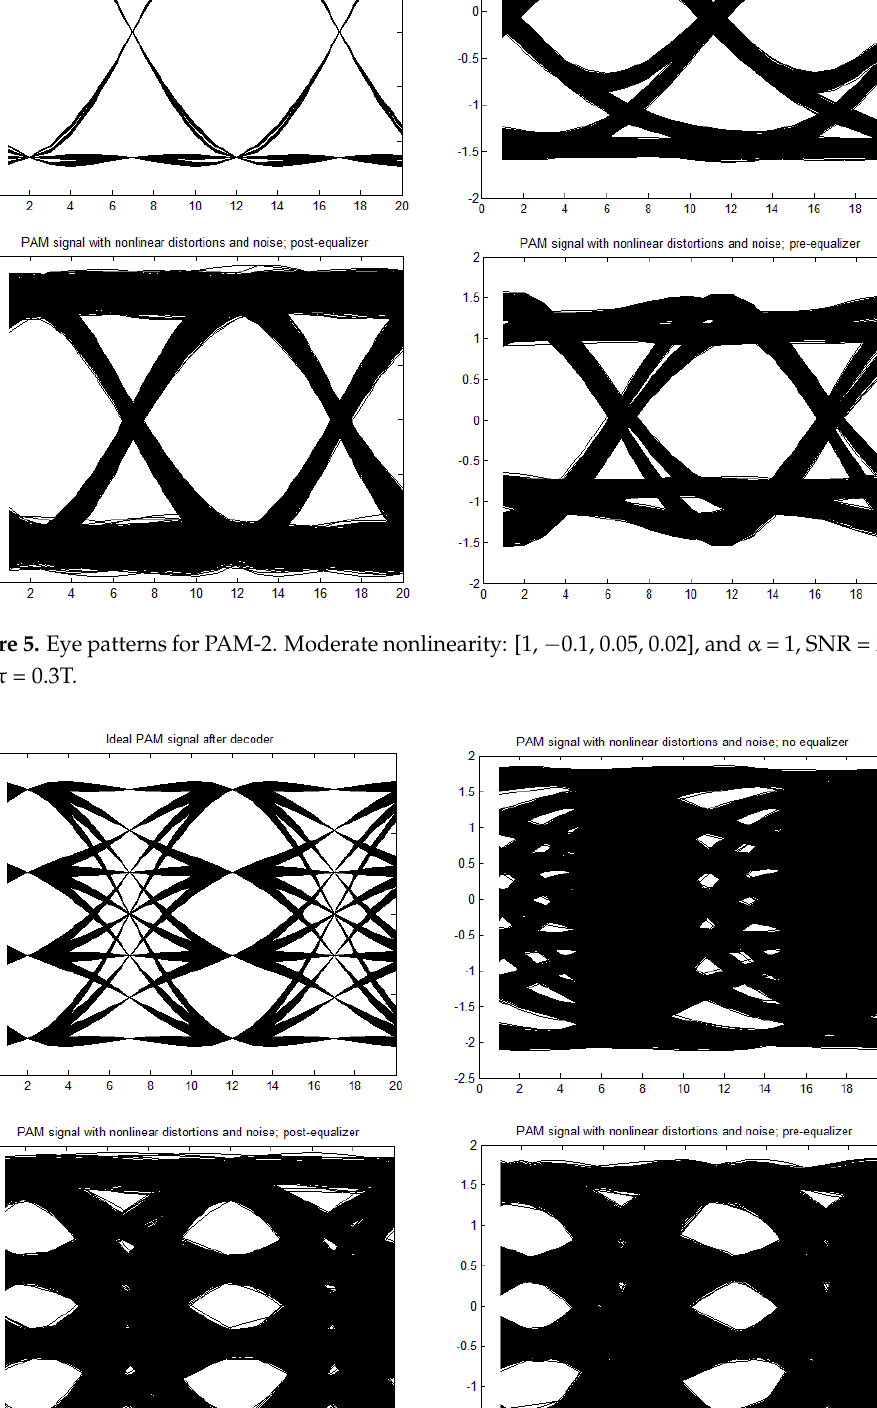
Figure 7. Eye patterns for PAM-8. Moderate nonlinearity: [1, − 0.1, 0.05, 0.02], and α = 1, SNR = 20 dB, and τ = 0.3T.